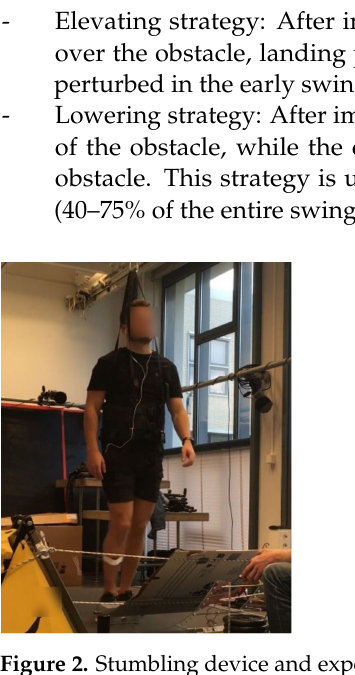
Figure 2. Stumbling device and experimental setup. One Ax6 inertial measurement unit (IMU) from Axivity, Newcastle upon Tyne, UK, was used during this study. The IMU was placed on the tibia, 20 cm below the patella, using sports tape for fixation to the skin. The sensor was set to record at 100 Hz, with an accelerometer range of ± 8 g and a gyroscope range of ± 500 dps. The placement and directions of the axes of the IMU are shown in Figure 3.